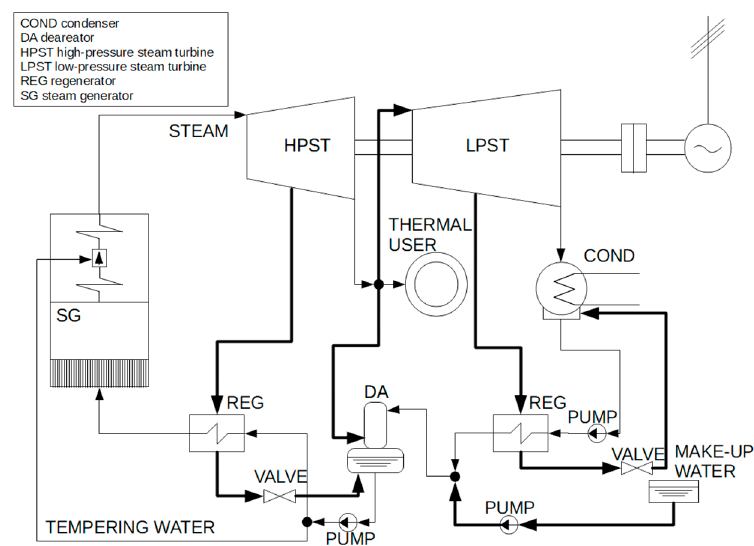
Figure 6. Scheme of the steam power plant with condensing turbine cogeneration unit taken into consideration.